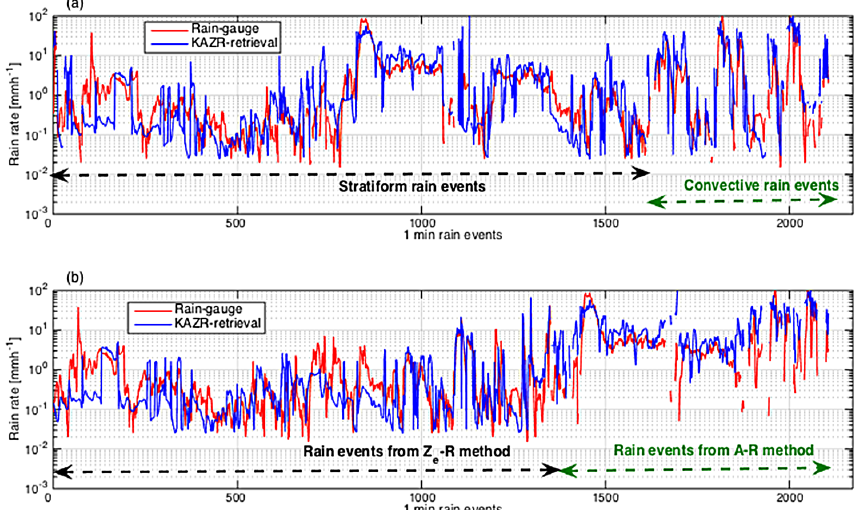
Figure 9. Time series of 1min averaged rain rates from the KAZR and a rain gauge covering 15 days of rain events between 8 October 2011 and 6 February 2012. (a) Rain rates are separated based on the regime type: stratiform (up to 1614min) and convective (1615–2168min) rain cases. (b) Rain rates are separated based on the method used to derive rain rates: Z e – R relationship (for DV< = 5ms − 1 ; up to 1344min) and A – R relationship (for DV>5ms − 1 ;